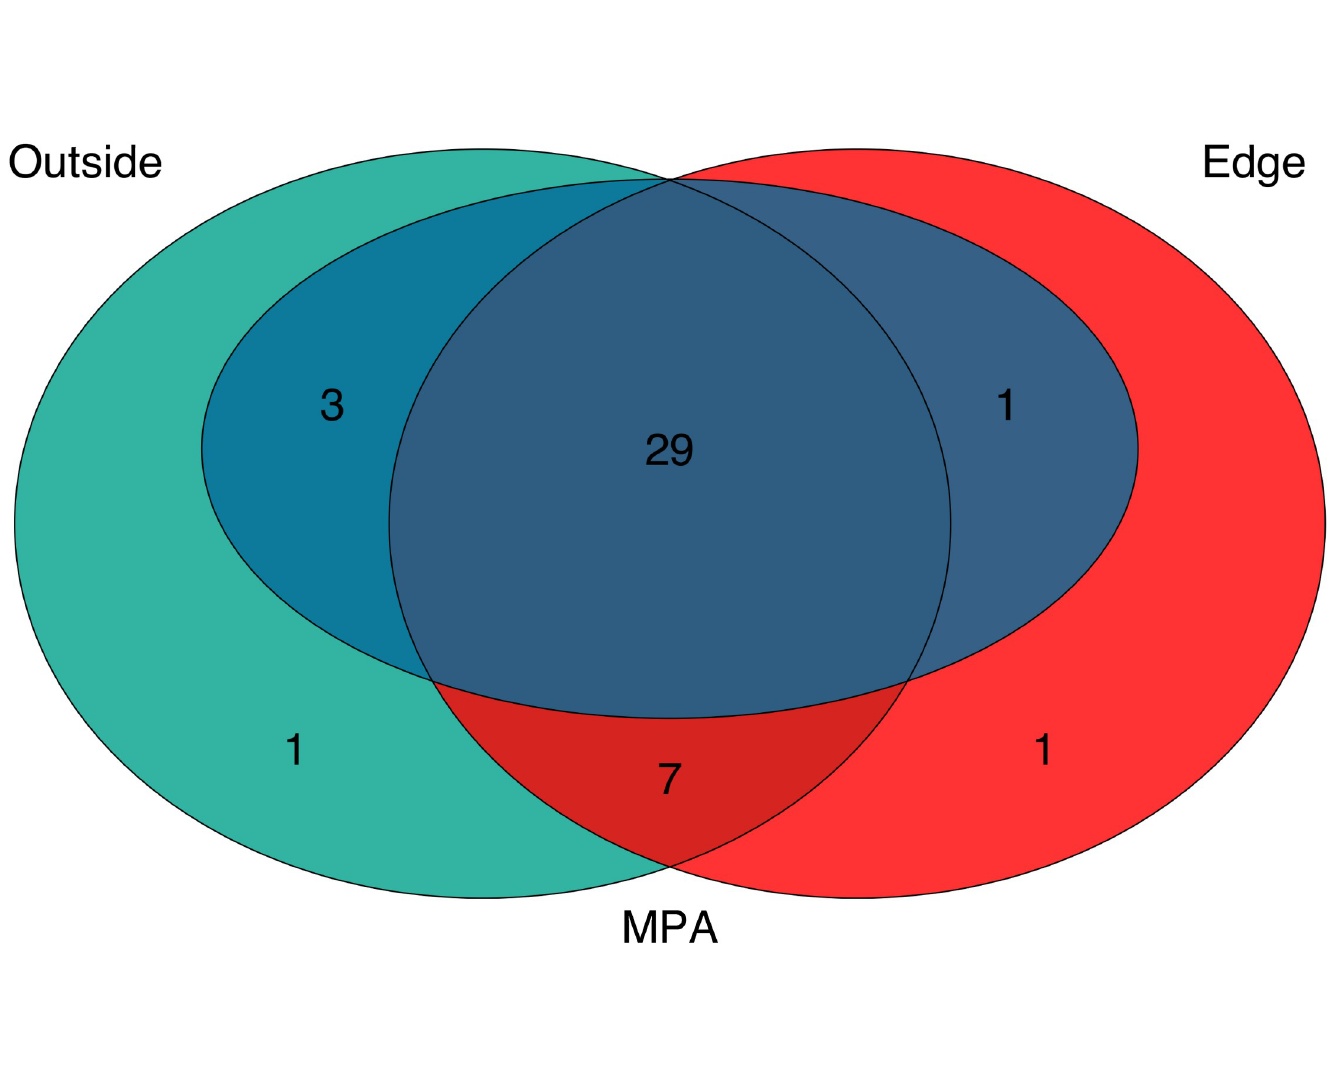
Fig 2. Venn diagram of fish species detected with